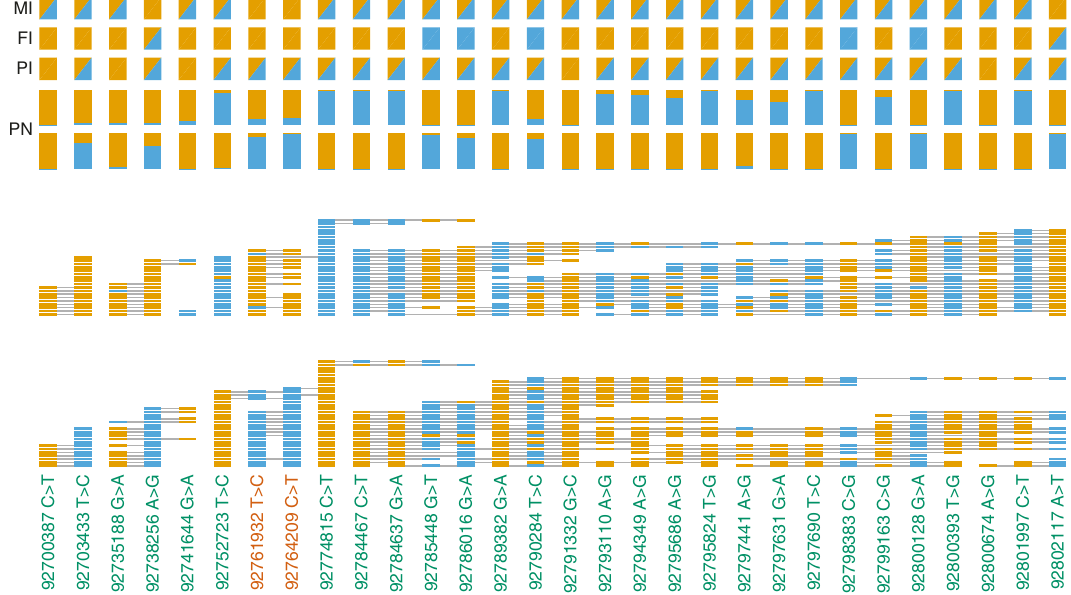
Fig. 3 Phasing clinical sample using ONT. Top of fi gure shows Illumina unphased genotypes for the mother (M I), father (F I) and proband (P I), as well as phased genotypes for the proband using ONT, at bi-allelic PASS SNVs identi fi ed by Illumina sequencing that have a heterozygote genotype in at least one member of the trio. Unphased genotypes are represented with triangles in boxes where blue = alt and orange = ref. Phased proband genotypes (P N) are represented by two rows of vertical bars, where each row is an arbitrarily labelled haplotype, and each bar is split by colour according to the probability of that haplotype having reference or alternate base. Middle of fi gure shows two rows with the reads for haplotype 1 or haplotype 2, where for each read, bases are rectangles, and read span is given by a horizontal line. Gaps represent either a gap (deletion), or a base that corresponds to neither the reference nor the alternate allele. Bottom shows physical position, with sites of interest in red. Note that some of the phase set containing the sites of interest extends another 150 kb distally but is not shown in the interests of clarity. Based on GRCh37 and NM_152703.3, 92761932T > C corresponds to c.3353 A > G whilst 92764209 C > T is corresponds to c.1076 G >